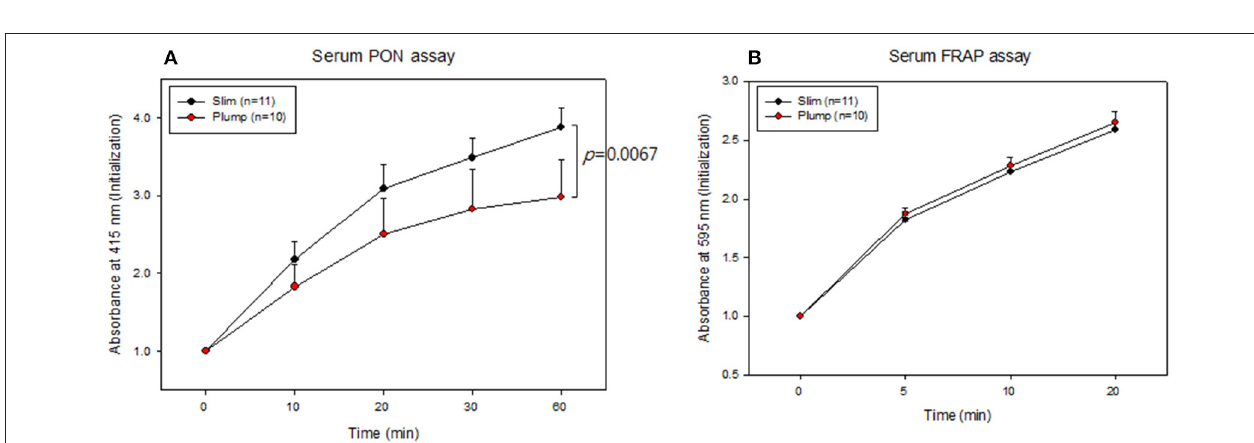
Uptake of LDL Into Macrophages After 48 h of treatment with each LDL, the plump group showed 2-fold higher oil-red O-stained area than the slim group